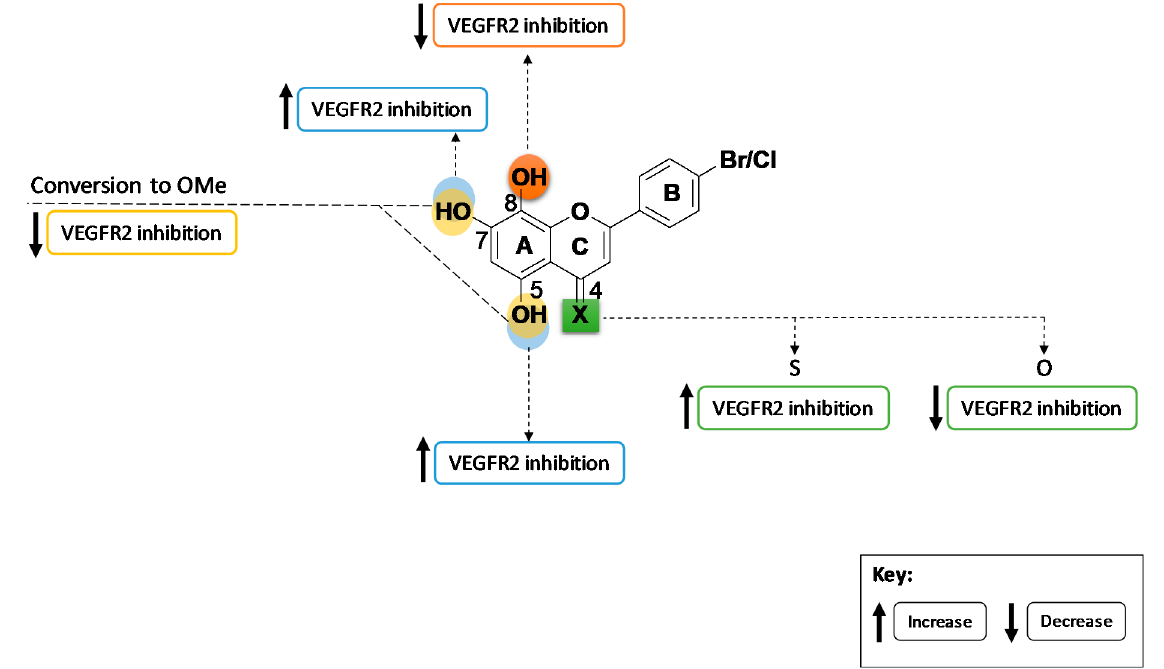
Figure 5. Summary of SAR of the tested panel of flavones on VEGFR2 phosphorylation inhibition.